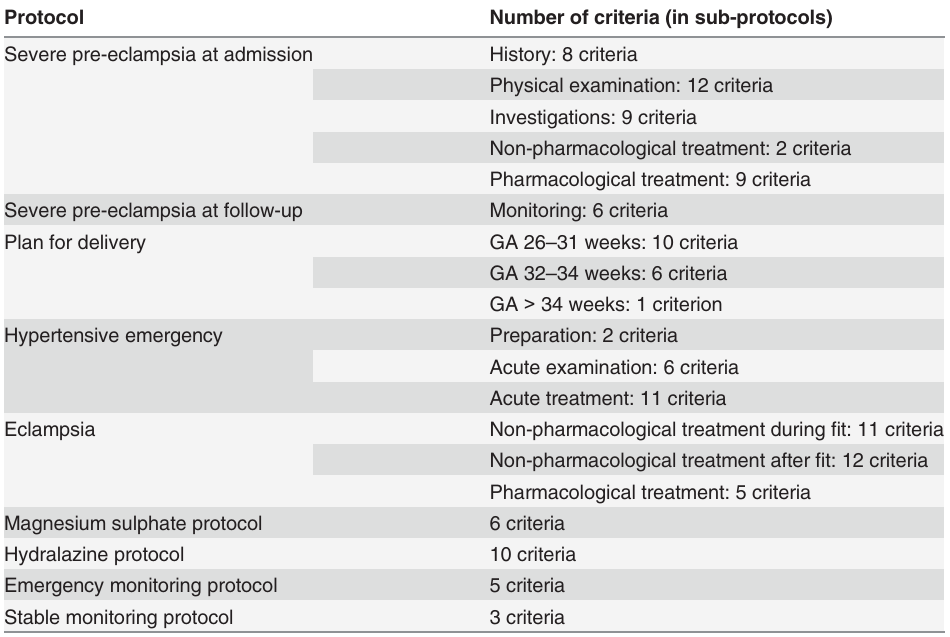
Table 1. Protocols used as standard of care with number of criteria per protocol, Ridge Regional Hos- pital, Accra, Ghana, 2013.